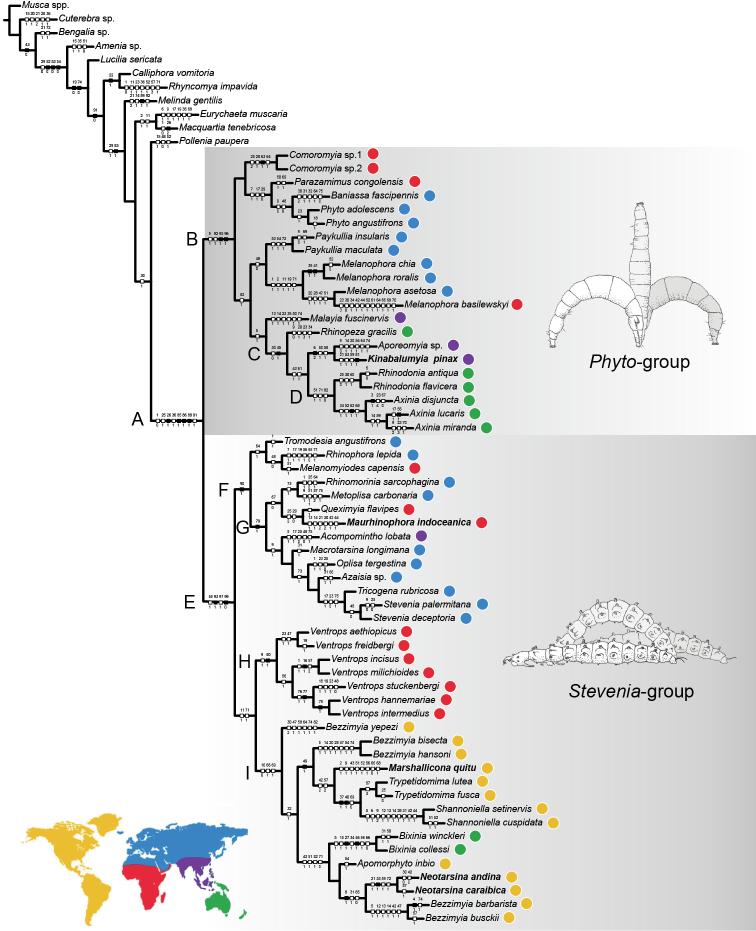
Phylogeny of Rhinophoridae based on morphological evidence. Single tree obtained under IW (total fit: 62.33), enforcing a k-value of 4, with unambiguous character state changes mapped above branches [black squares: global apomorphies (i.e., uncontradicted and unreversed apomorphic character states; white squares: local apomorphies (i.e., homoplasious character state due to convergence or reversal)] and new taxa highlighted in bold.